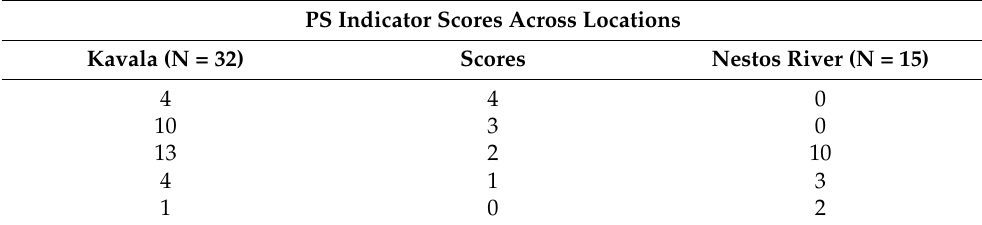
Table 2. Mann–Whitney U test across farmer’s current location and the PS